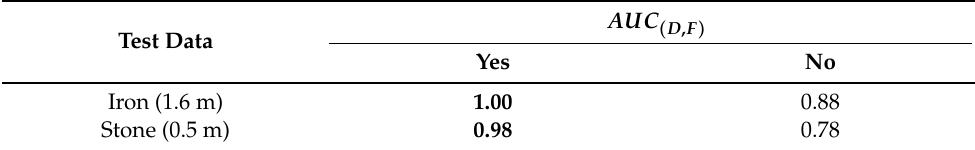
Figure 20. The result of the methods with and without a domain adaptive for a 1.6 m iron plate, stone disc. Table 9. Comparison of effect with and without domain adaptive, ‘ Yes ’ is with domain adaptive, ‘ No ’ is without domain adaptive.